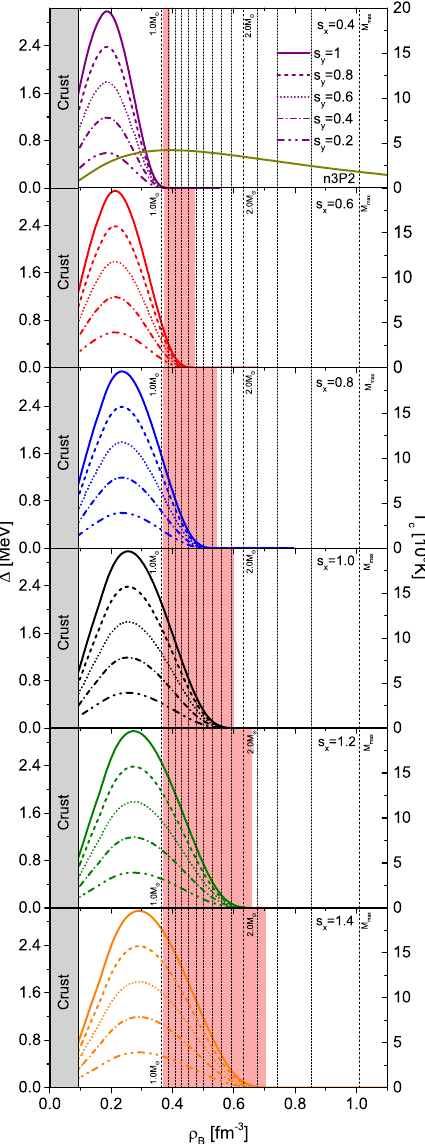
Figure 3. V18 BCS p1S0 pairing gap in NS matter as a function of baryon density with different scale factors s x and s y applied. The unscaled n3P2 gap is also shown for comparison in the top panel. Vertical dotted lines indicate the central densities for different NS masses M / M (cid:12) = 1.0,1.1,1.2, . . .. The shaded red areas indicate the blocking of DU